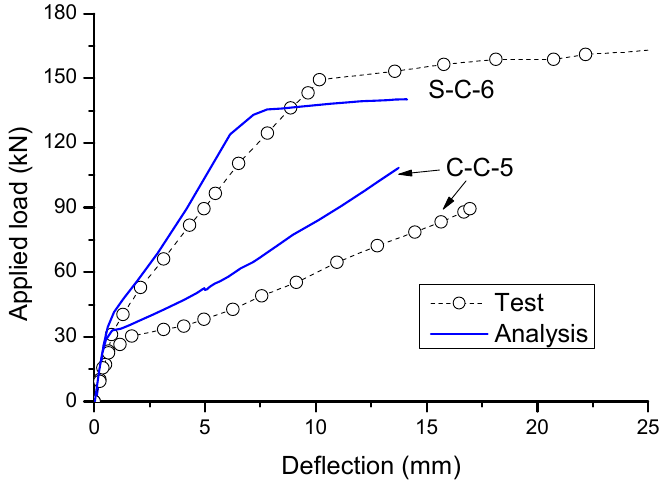
Figure 2. Comparison of numerically obtained load–deflection curves with experimental data.